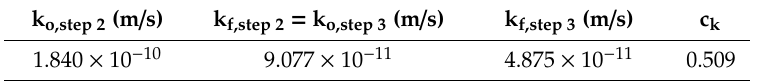
Table 5. First application. c k and initial and final hydraulic conductivities for loading steps 2 and